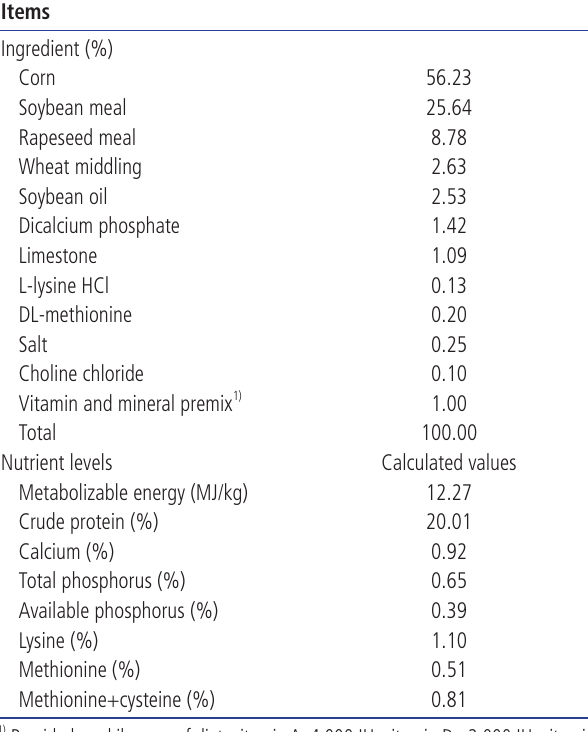
Table 1. Composition and nutrient levels of the basal diet (as-fed basis)